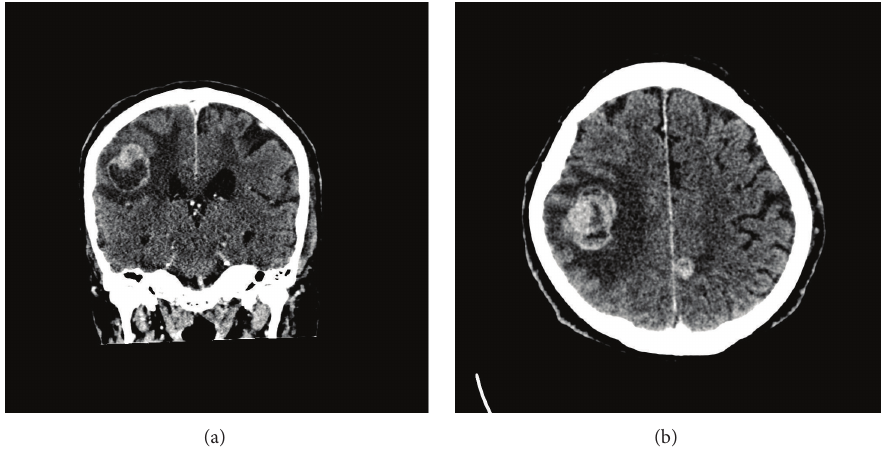
Figure 4: CT imaging of brain metastases in the coronal (a) and axial (b)